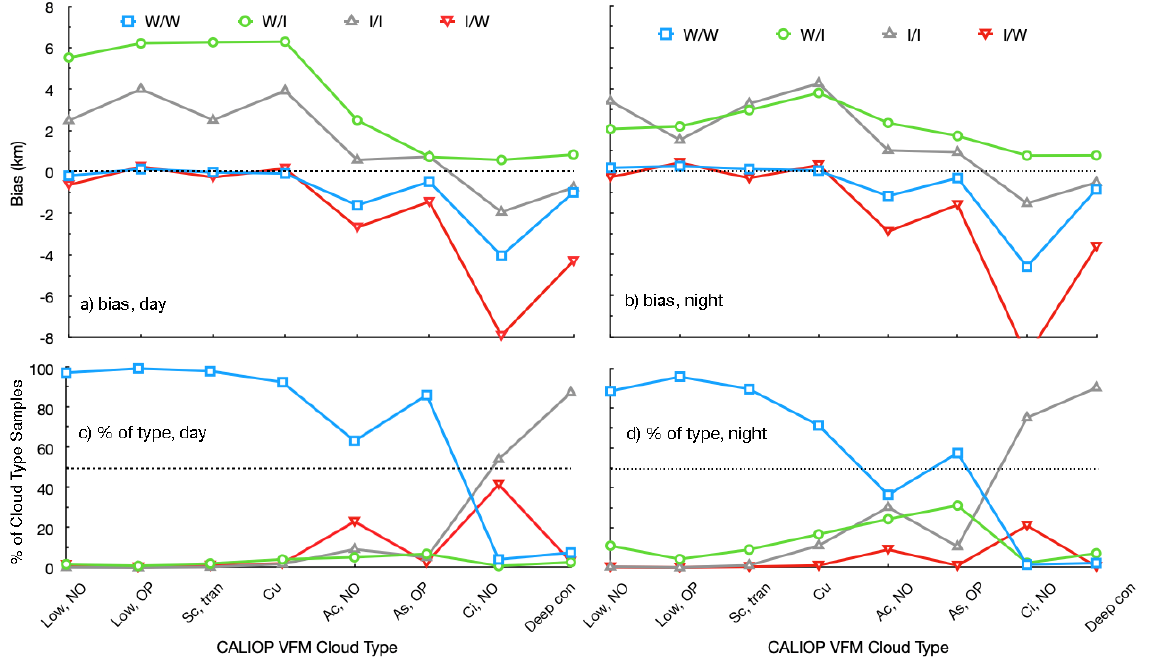
Figure 20. Cloud-top height biases, ∆ Z , as a function of CALIOP/CV1S cloud-top phase agreement for CALIOP VFM cloud types, JAJO 2015–2016, | ∆ t | ≤ 15 min. W and I represent water and ice, respectively. ( a , b ): Biases, ( c , d ): Percent of each phase pair comprising the cloud type samples. ( a , c ): Day. ( b , d ): Night.